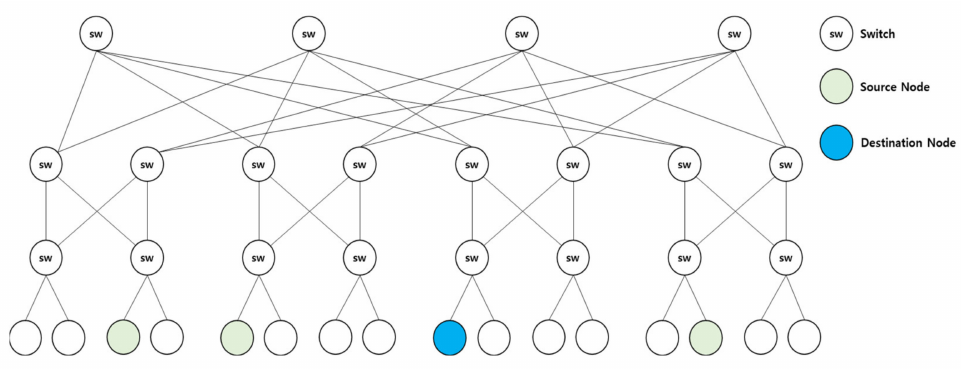
Figure 7. Example of applying EC to fat-tree network